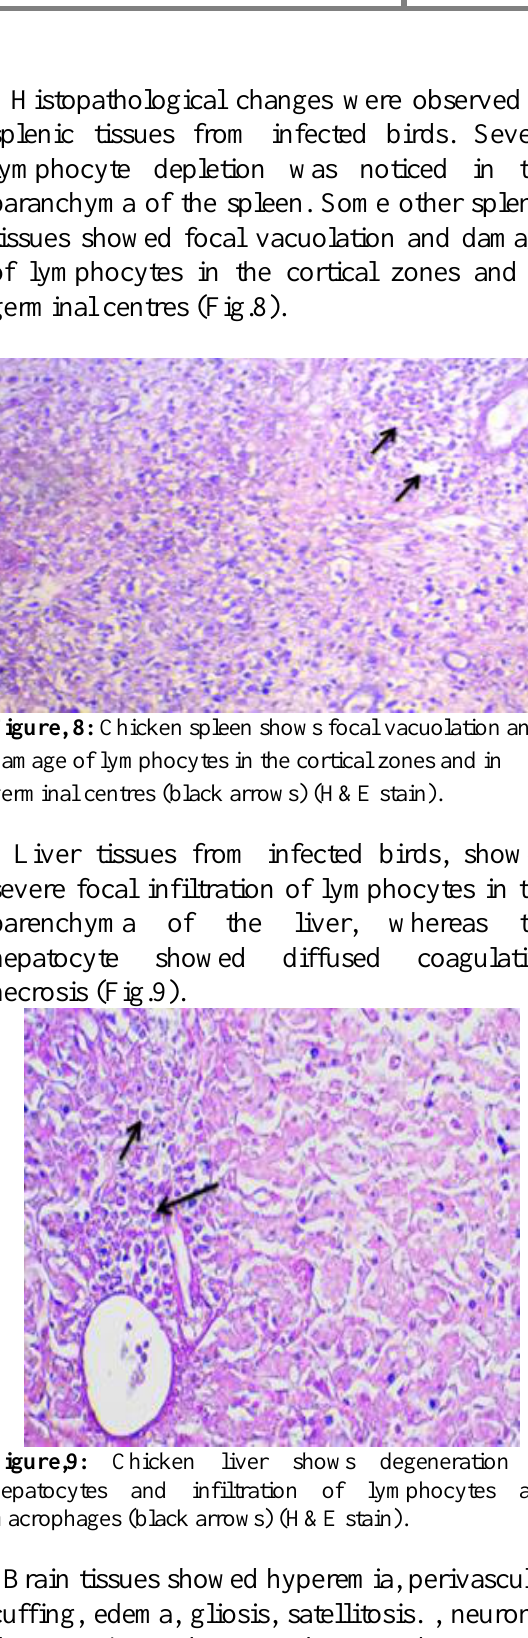
Figure,7: Chicken intestine showed extensive ulceration of intestinal epithelium and infiltration of lymphocytes and macrophages (lack arrows) (A&B).